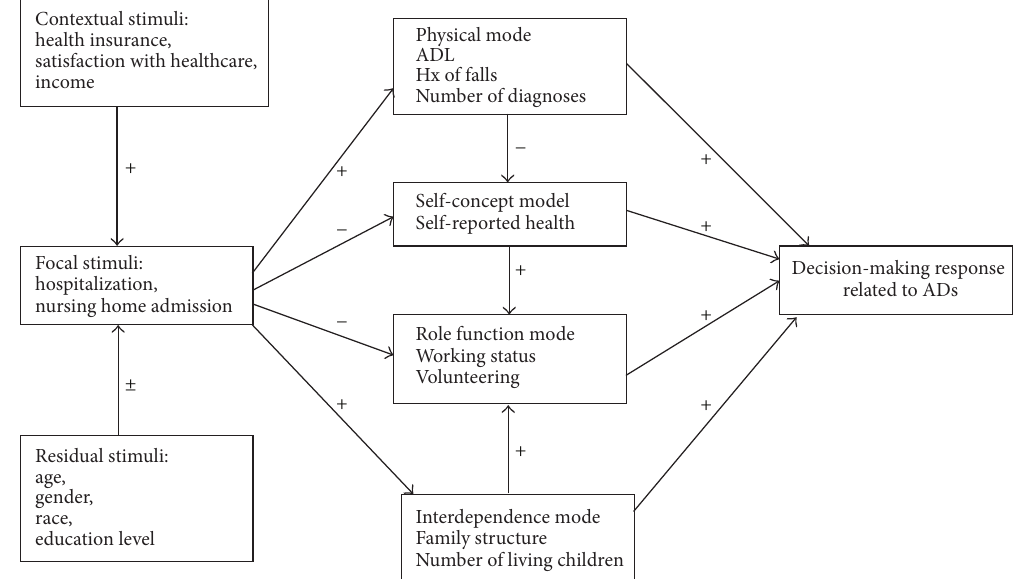
Figure 1: Application of the RAM to AD